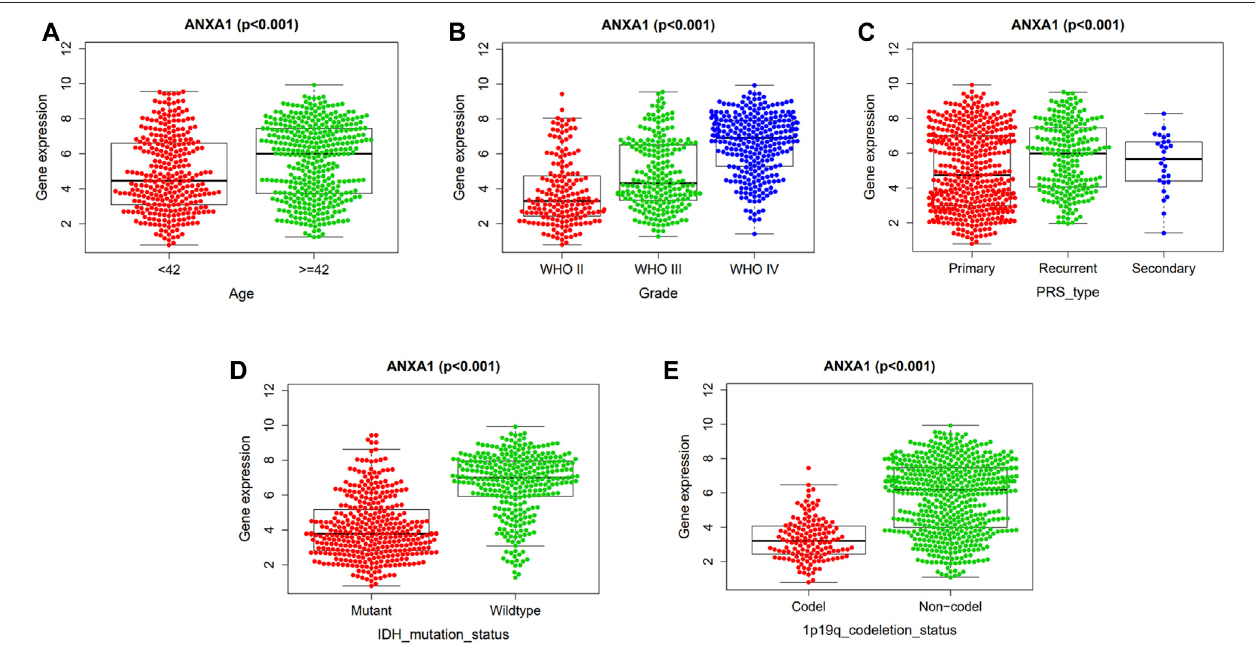
FIGURE4| IndependentanalysisoftheANXA1geneandclinicopathologicalfeatures.Basedon686tumorsamplesintheCGGAdatabase,theANXA1andclinical characteristics were analyzed independently: (A) Expression of ANXA1 in age ( ≥ 42 years, < 42 years). (B) Expression of ANXA1 in glioma grade (WHO II, WHO III, and WHO IV). (C) Expression of ANXA1 in glioma types (primary, recurrent, and secondary). (D) Expression of ANXA1 in IDH mutation state (mutant and wild-type). (E) Expression of ANXA1 in 1p19q codeletion status (Codel and non-codel).